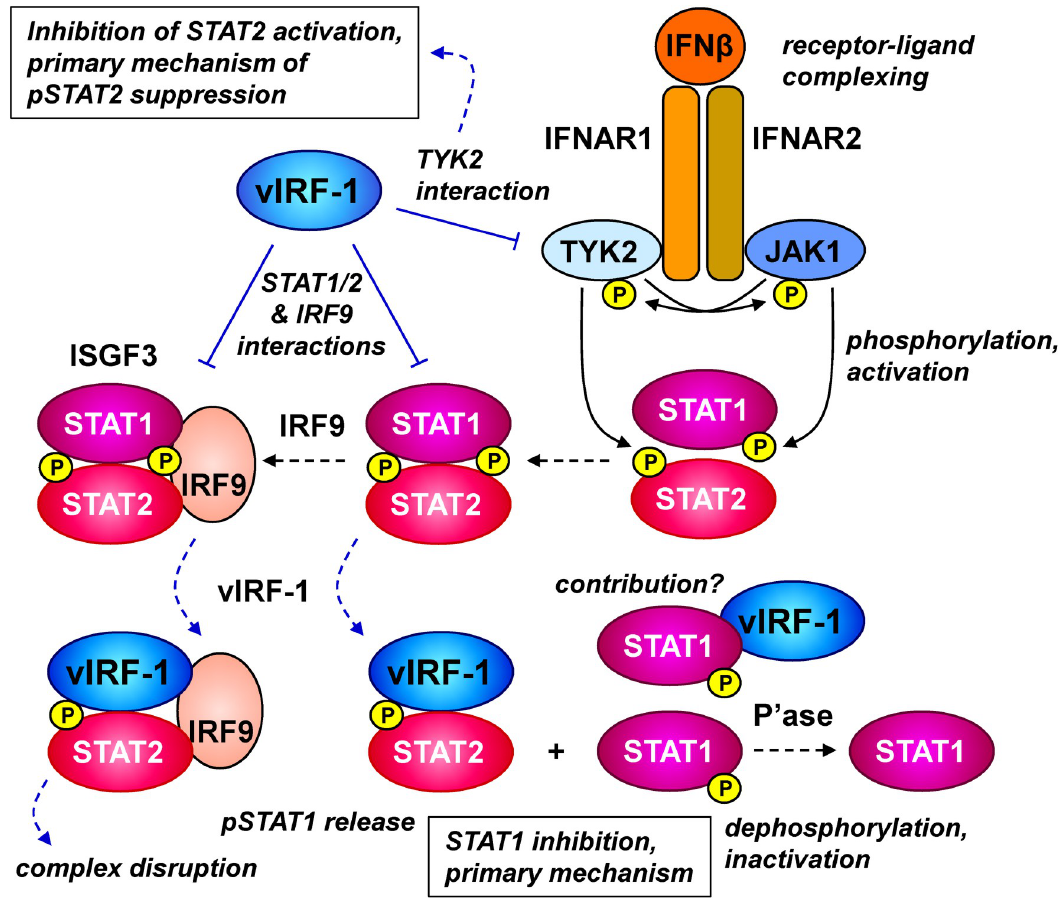
Fig 7. Model of vIRF-1 inhibition of IFN- β signaling based on the presented data. IFN β binds to IFNAR1 and IFNAR2 to effect receptor activation through auto/cross-phosphorylation of receptor associated JAK kinases (JAK1 and TYK2) and receptor tyrosine residues. STAT1 and STAT2 are recruited and activated through JAK-mediated tyrosine phosphorylation, and then can heterodimerize and associate with IRF9 to form nuclear-localizing and transcriptionally active ISGF3 complexes. Data presented here show that vIRF-1 binds directly to STAT1, STAT2 and IRF9 and can also associate, directly or indirectly, with TYK2 and JAK1. vIRF-1 inhibits TYK2, but not JAK1, autophosphorylation (activation), likely contributing to pSTAT2 suppression; vIRF-1 also inhibits TYK2-STAT2 and TYK2-IFNAR1 association (not illustrated). However, suppression of pSTAT1 is mediated largely after IFN β -induced STAT1 phosphorylation, involving increased rates of pSTAT1 decay, likely via phosphatase (P’ase)-mediated dephosphorylation (rather than pSTAT1 degradation). Suppression of pSTAT1 by vIRF-1 is dependent on STAT2, being negated by STAT2 knockout in 293T cells; this along with decreased IFN β -stimulated pSTAT1 association with STAT2 and IRF9 in the presence of vIRF-1 indicates that vIRF-1 may suppress pSTAT1 via release of the transcription factor from ISGF3 or STAT1-STAT2 heterodimers, thereby promoting dephosphorylation of pSTAT1. Detection of intracellular complexes containing vIRF-1, pSTAT2 and IRF9 and dissociation of IFN β -induced STAT1-STAT2 interaction by vIRF-1 in vitro are consistent with this model. Data from in vitro competition and STAT1/IRF9 and IRF9/STAT2 serial precipitation experiments provide evidence that vIRF-1 may also destabilizes IRF9-STAT2 association and dissociate ISGF3 interactions. It is possible that vIRF-1 also inhibits ISGF3 complex formation (not illustrated), via (detected) interactions with pre- and/or post-activated STAT1, STAT2 and IRF9, but the presented data do not specifically address this. In the diagram, blue lines indicate activities and consequences of